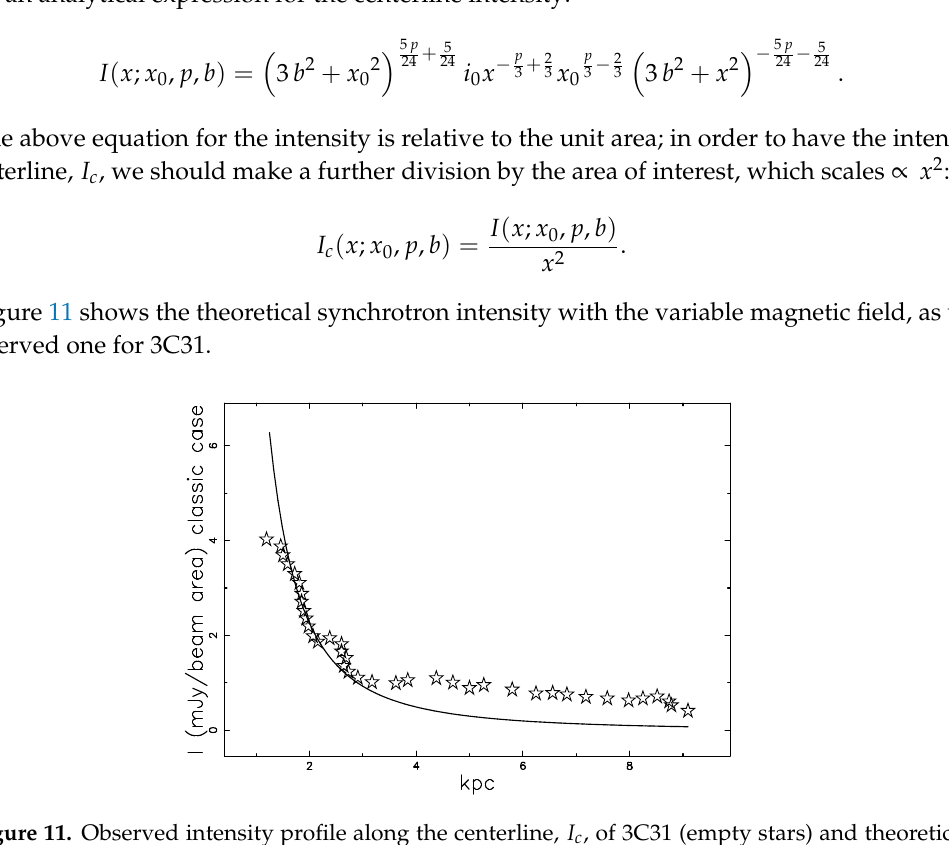
Figure 11. Observed intensity profile along the centerline, I c , of 3C31 (empty stars) and theoretical intensity as given by Equation (76), with parameters as in Table 1. The observational percentage of reliability is (cid:101) obs =